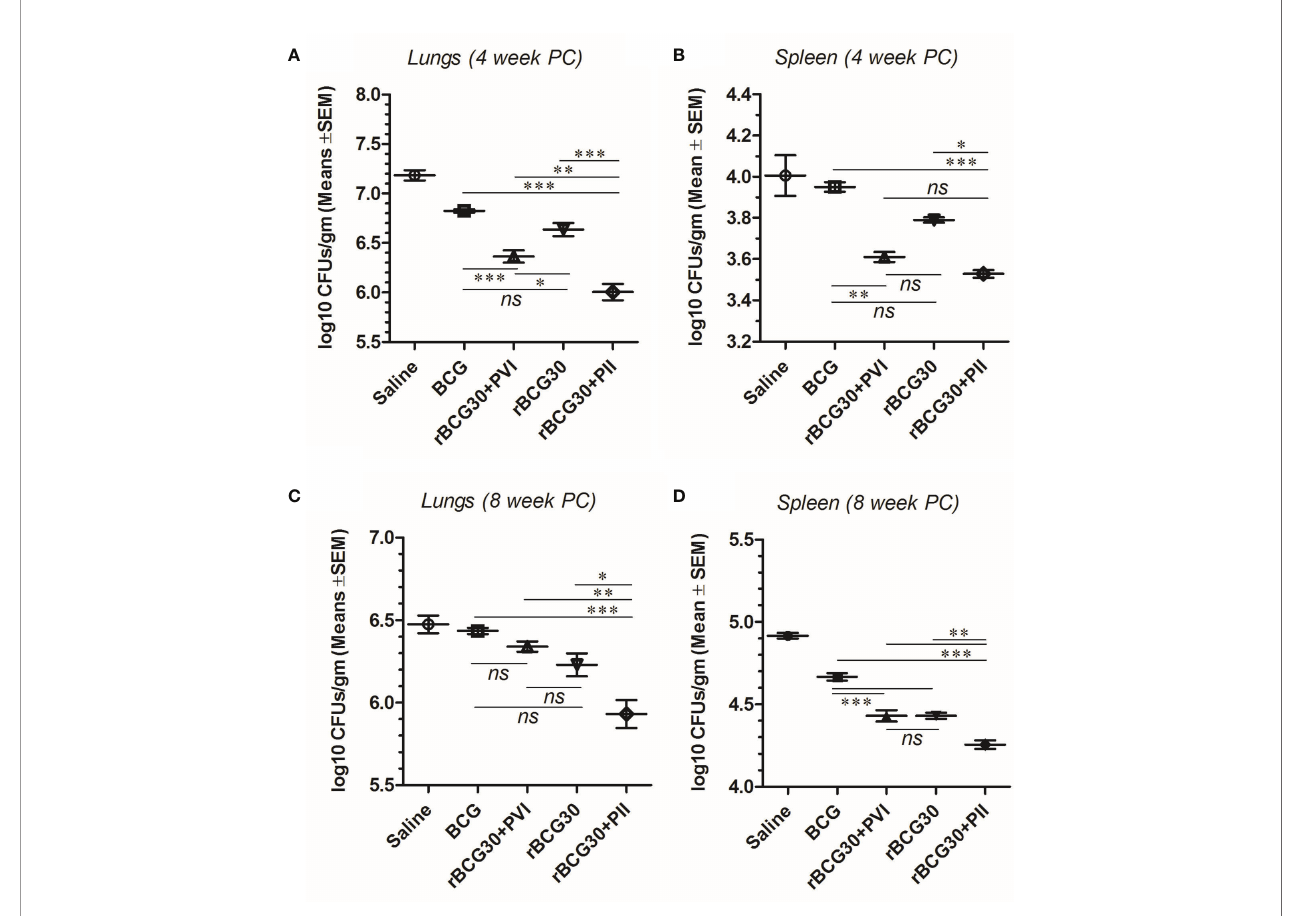
FIGURE 10 | Residual Mtb burdens in the lungs and spleen of the infected mice. Mtb bacillary load was assessed in rBCG30-immunized and DPP treated (both PVI and PII setups) mice at week 4 and 8 post aerosol Mtb challenge. CFU loads in the organ homogenates were enumerated and expressed as log10 CFU/g of tissue. The scatter plots in the fi gure represent log10 CFU/g ± SD (of at least fi ve biological replicates per group) in lungs and spleen at (A, B) 4; as well as (C, D) 8 weeks post-challenge, respectively. CFU data were analyzed by employing one-way ANOVA followed by Tukey ’ s post-test, where p< 0.05(*), p< 0.01(**), and p< 0.001(***) were considered signi fi cant. ns, non-signi fi